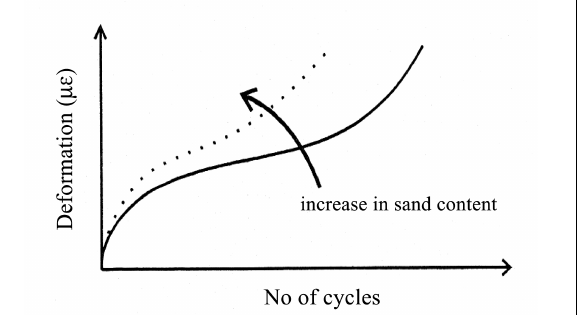
Fig 2. Permanent deformation of a mix